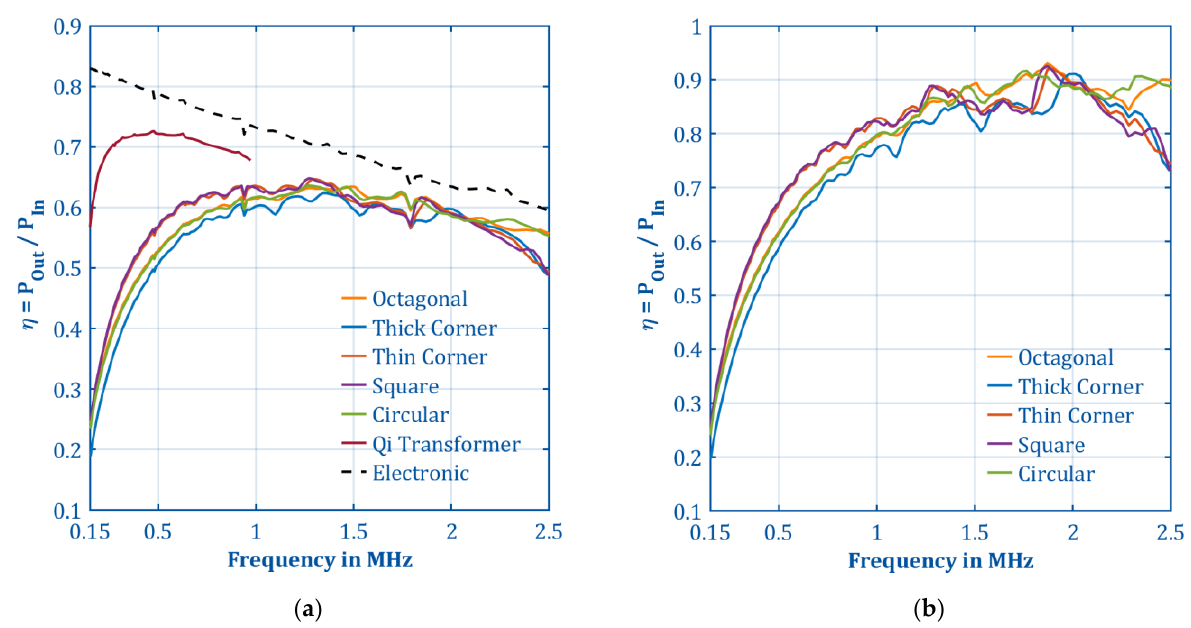
Figure 9. ( a ) Measurement of the efficiency of the transformers (Octagonal, Thick Corner, Thin Corner, Square, Circular, Qi Transformer) including losses of the control electronics (Electronic marked with a dashed line) at a constant output power of 5 W. ( b ) Measurement of the efficiency of the PCB transformers without losses caused by the control electronics at a constant output power of 5